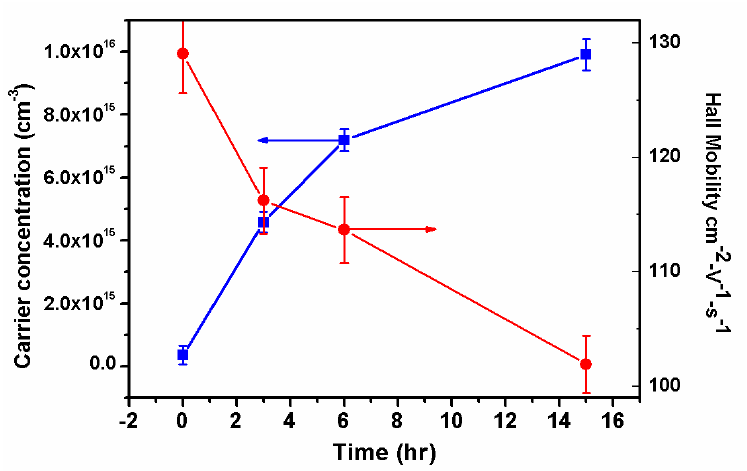
Figure 3. Carrier concentration and mobility data for ZnO samples with Cu diffusion for 3 h, 6 h, and 15 h.